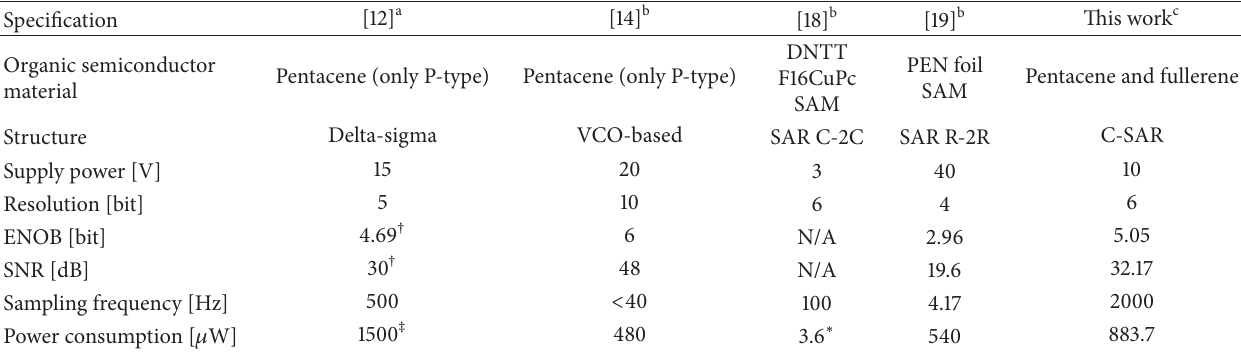
Table 2: Performance summary of current organic ADCs.